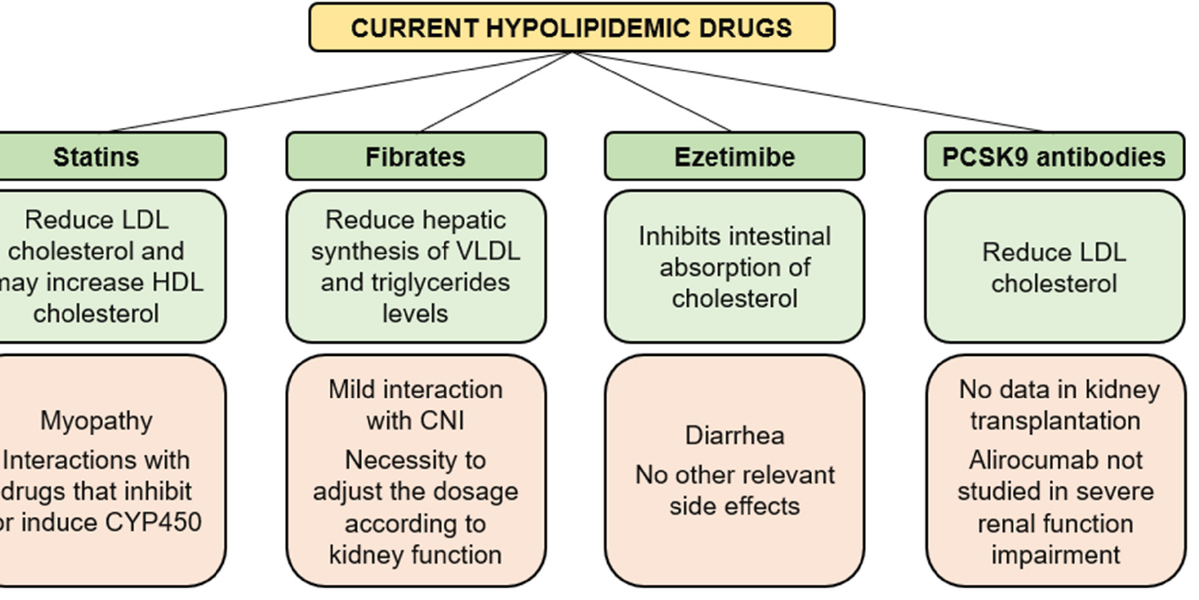
Figure 3. Advantages (light green) and concerns (light orange) of the available hypolipidemic drugs. CNI, calcineurin inhibitors; CYP450, cytochromes P450; HDL, high-density lipoproteins; LDL, low-density lipoproteins; PCSK9, proprotein convertase subtilisin/kexin type 9. HMG-CoA reductase inhibitors, also called statins, may reduce LDL, increase high- density lipoproteins (HDL) and slightly decrease triglycerides [88]. Statins are the first- line treatment of hypercholesterolemia and are recommended for people with an LDL cholesterol level higher than 190 mg/dL [89]. Since statins and CNI are both metabolized by the P450 cytochrome (CYP450) enzymatic system, pharmacokinetic interactions are